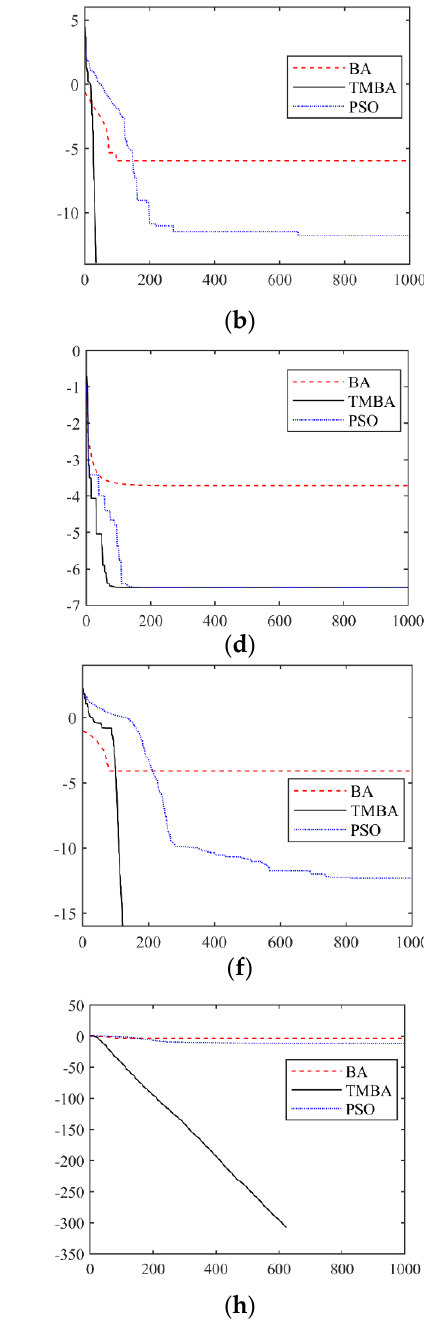
Figure 12. Trend of the convergence accuracy in the optimization process. ( a ) Ackley 1 Fcn; ( b ) Bartels Conn Fcn; ( c ) Bohachevsky 2 Fcn; ( d ) Cross in Tray Fcn; ( e ) Drop Wave Fcn; ( f ) Griewank Fcn; ( g ) Schwefel 2.21 Fcn; ( h ) Sphere Fcn.